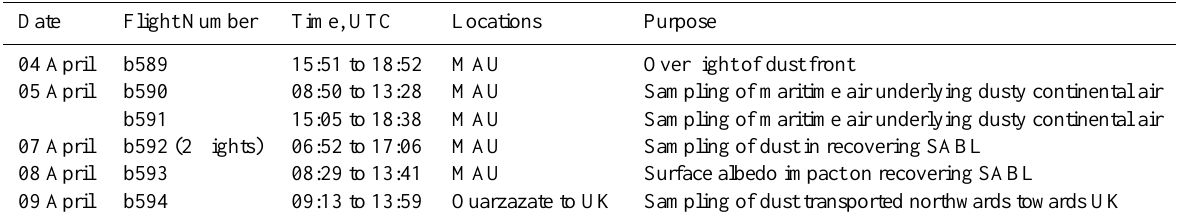
Table 5. April 2011 pilot campaign flights of BAe146. MAU stands for